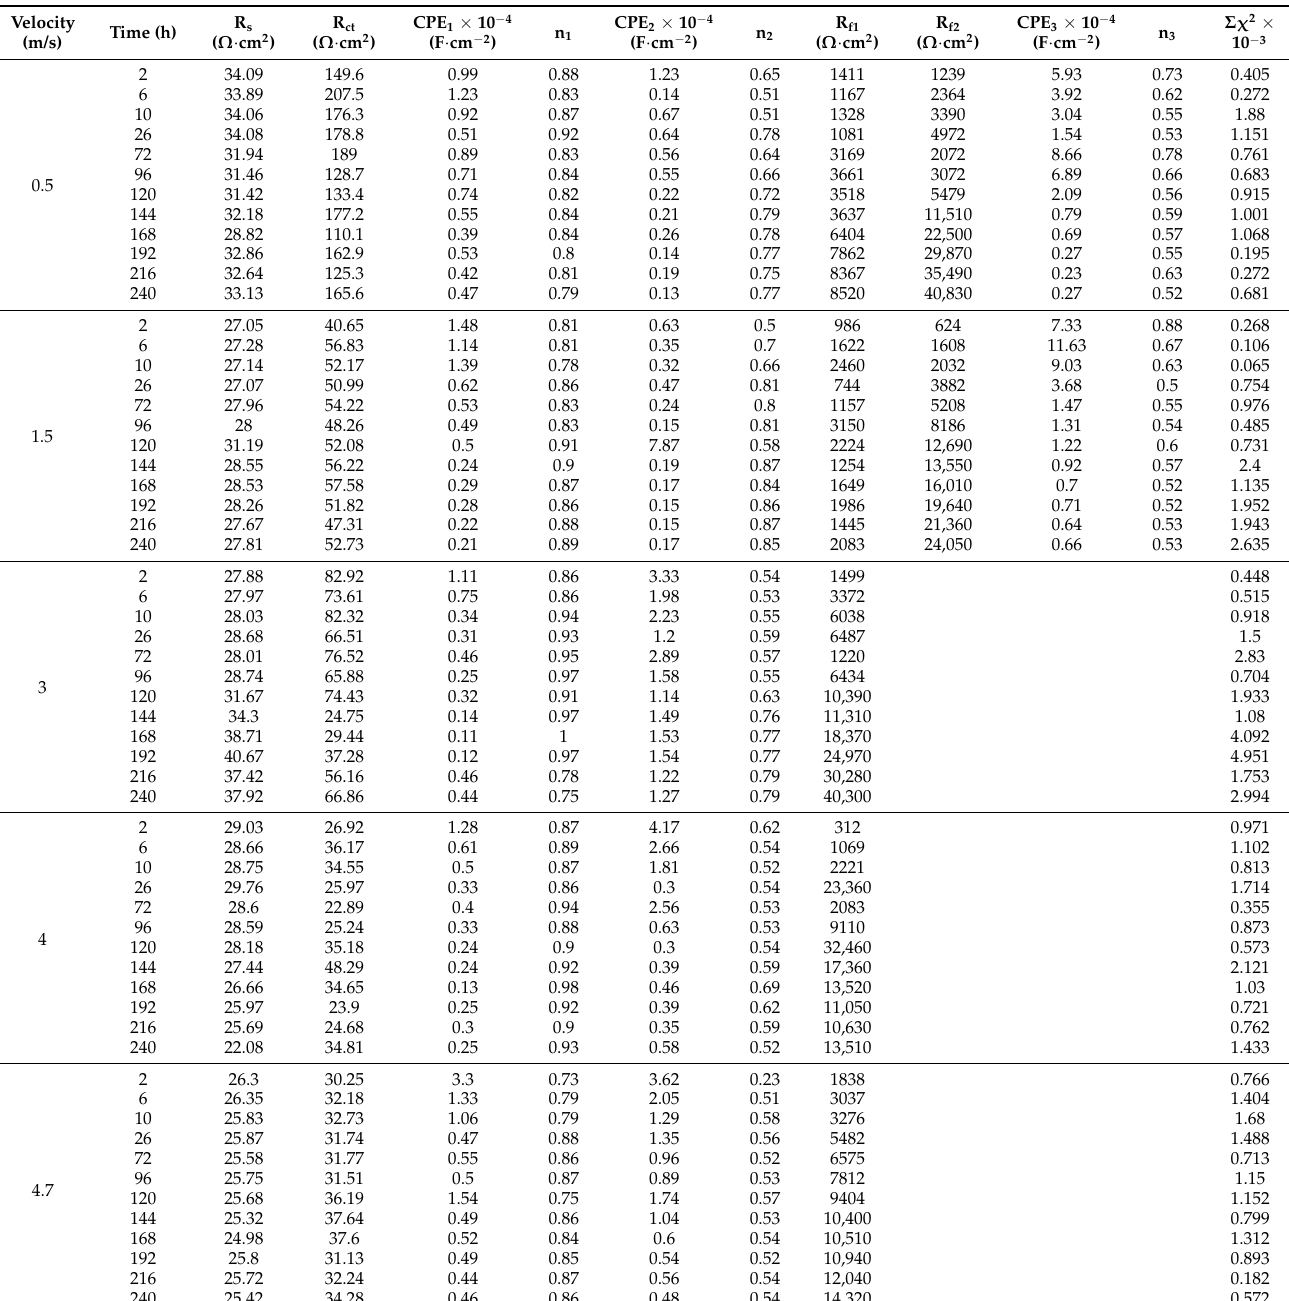
Table 3. Electrochemical parameters of 70/30 copper–nickel samples obtained by fitting EIS